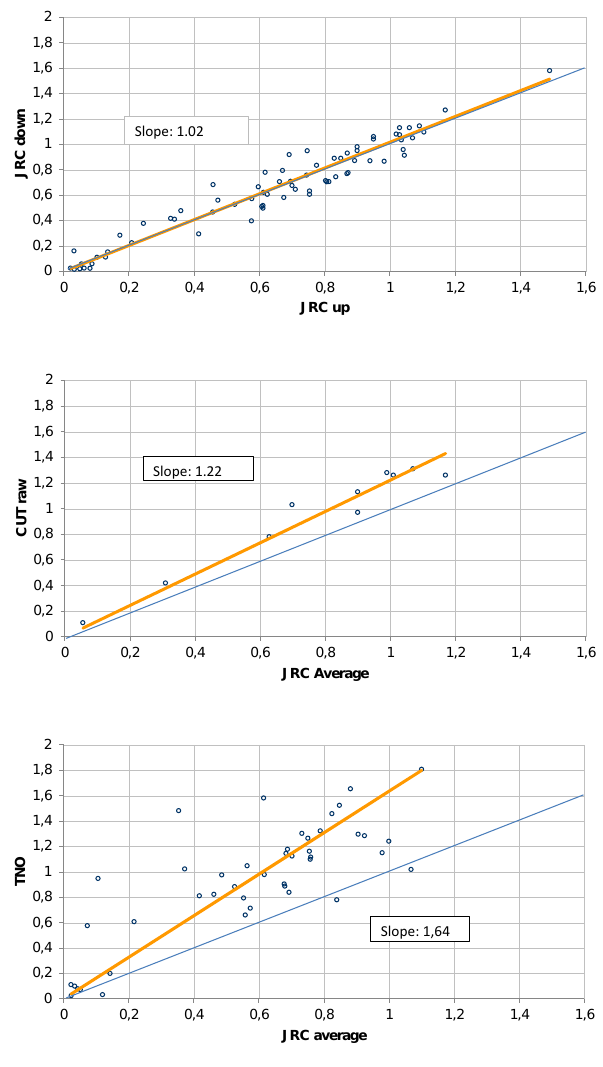
Figure 3. Comparison of FSC, expressed in percent sulphur by mass in fuel, determined by “sniffer” measurements (see text). “JRC up” and “JRC down” are the two JRC sampling points, “JRC Average” is the average of these two points. “CHA” and “TNO” are the mea- surements performed at the same time on the same ship. Regression lines, forced through (0 , 0) have been obtained by orthogonal re- gressions. The number of outliers removed is 3 in the upper figure, 1 in the middle figure and 2 in the lower figure.